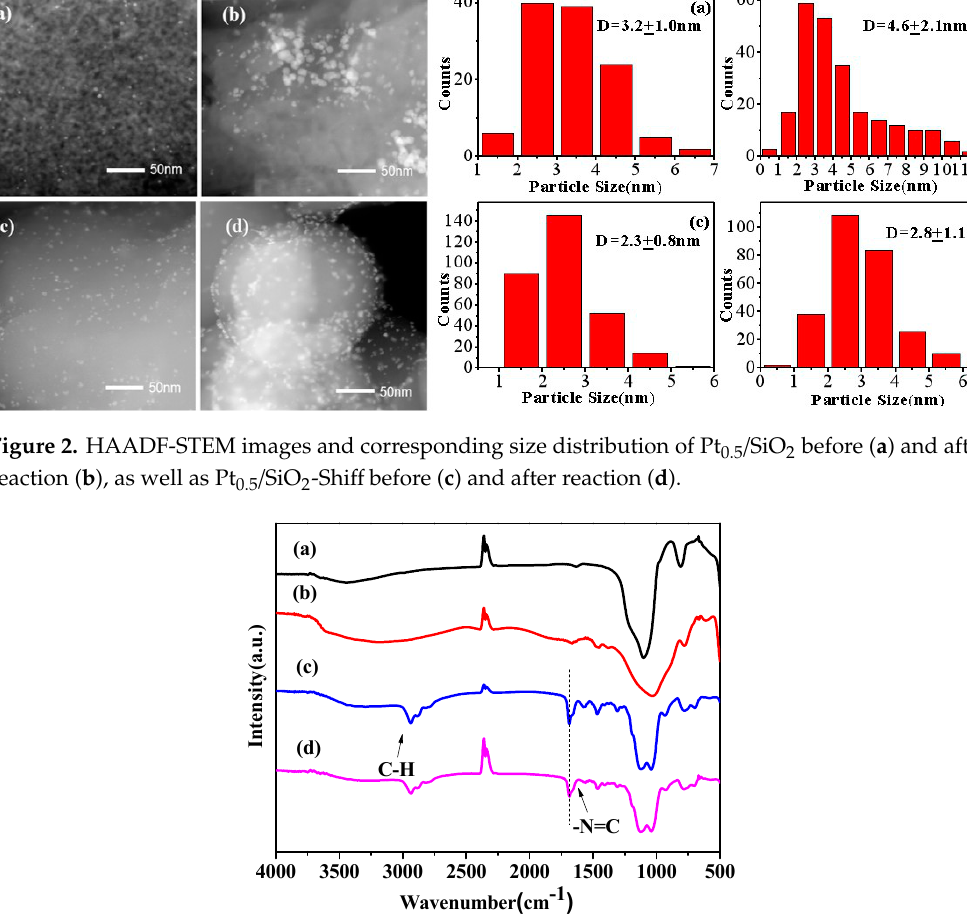
Figure 2. HAADF-STEM images and corresponding size distribution of Pt 0.5 /SiO 2 before ( a ) and after reaction ( b ), as well as Pt 0.5 /SiO 2 -Shiff before ( c ) and after reaction ( d ).